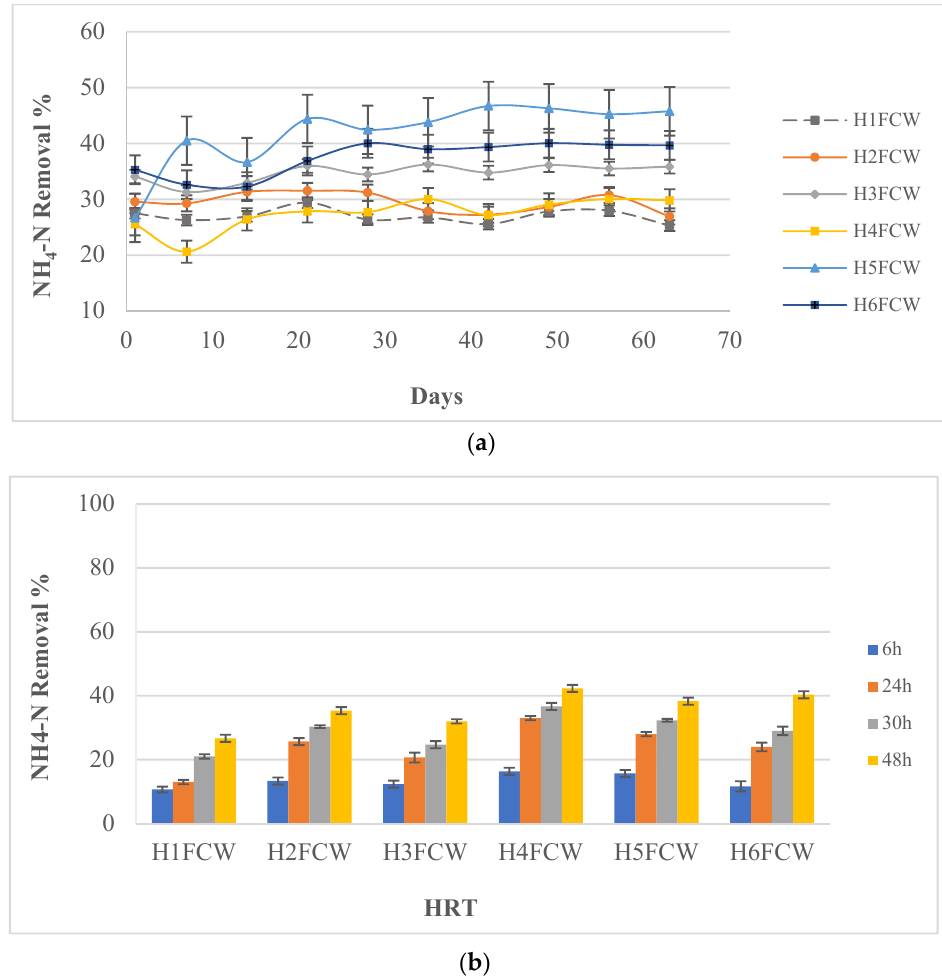
Figure 4. ( a ) Ammonium removal rates in different mesocosm HFCWs after 48 h. ( b ) Hydraulic retention time effect on ammonium removal.